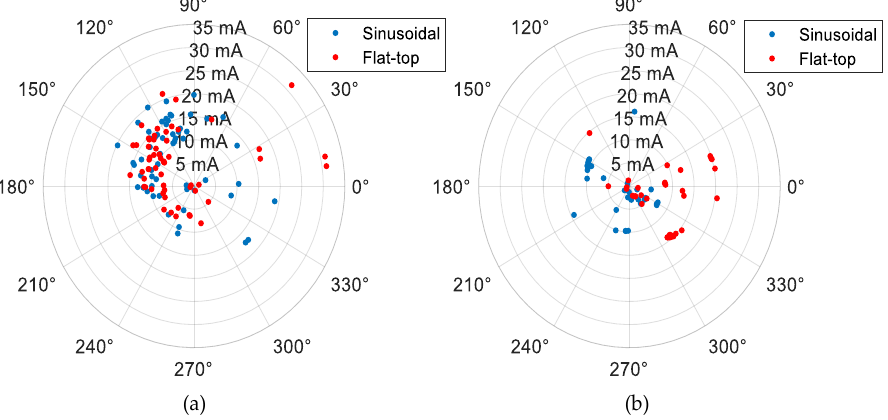
Figure A7. Thirteenth harmonic current emission of the selected lamps under the two types of supply voltage: ( a ) CFL and ( b ) LED lamps.